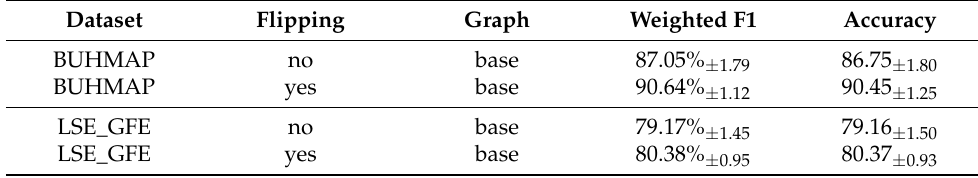
Table 7. Ablation study for data augmentation through horizontal